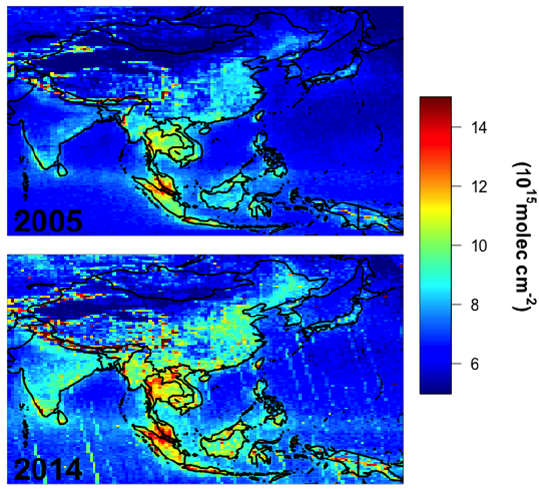
Figure 14. Annual average HCHO columns measured by the OMI instrument in 2005 and